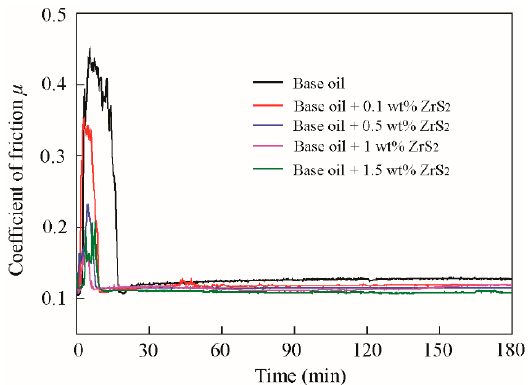
Figure 5. ( a )friction coefficient and (b) running ‐ in time of the base oil and that with different concentrations of lamellar ZrS 2 nanobelt additives